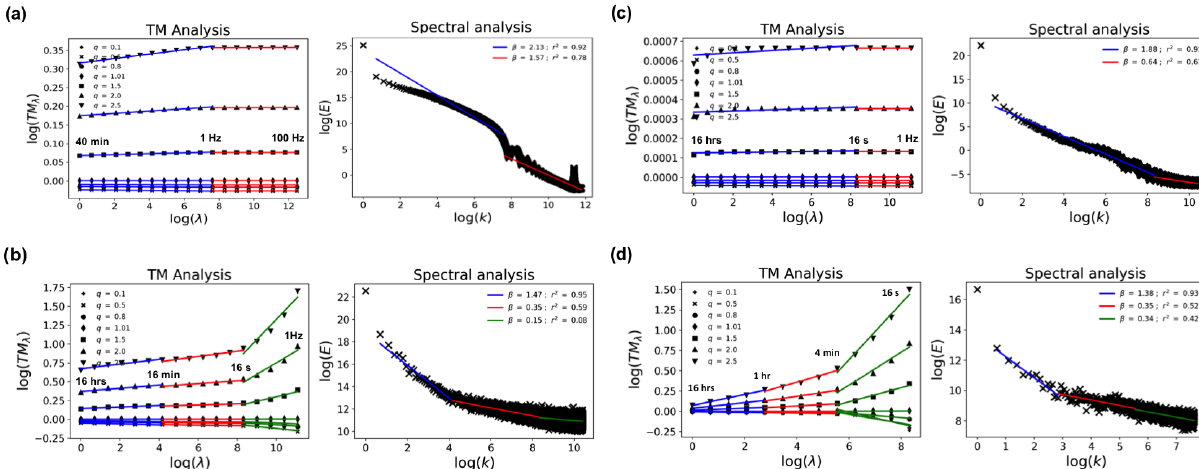
Figure 9. TM analysis (Eq. 4 in log-log plot), and spectral analysis (Eq. 3 in log-log plot) of 1 month long data (27 January to 27 Febru- ary 2021) for (a) anemometer data at 100Hz (sample length of 40min), (b) fluctuations of anemometer data at 1Hz (sample length of 16h), (c) Temperature ( T ) at 1Hz (sample length of 16h), (d) fluctuations of Temperature ( T ) at 15s (sample length of